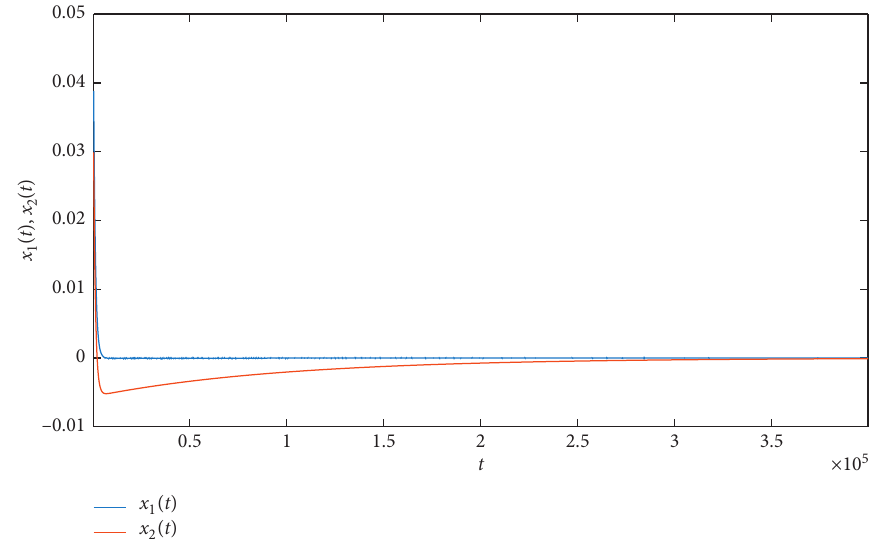
( t ) ,x ( t ) of system (39) when I 1 2